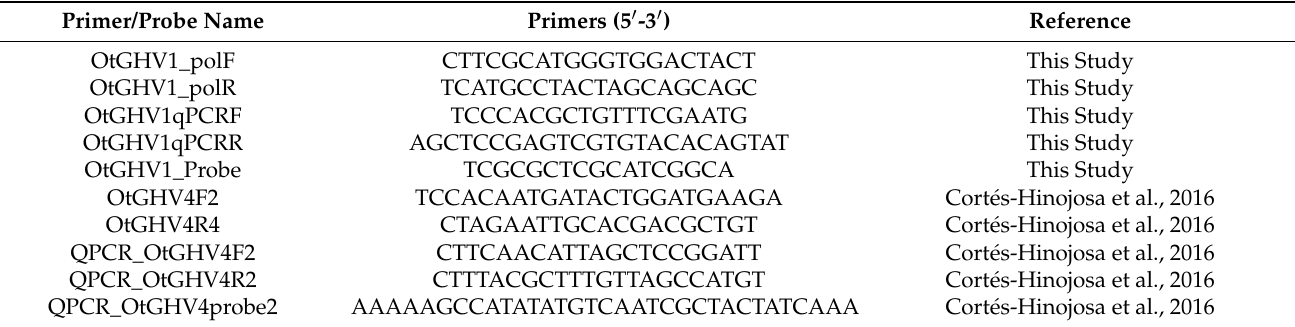
Table 1. PCR and qPCR primers and probes used for OtHV1 and OtHV4 qPCR